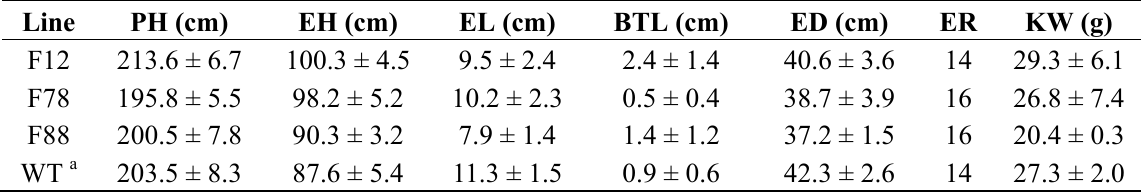
kernels in three transgenic 2